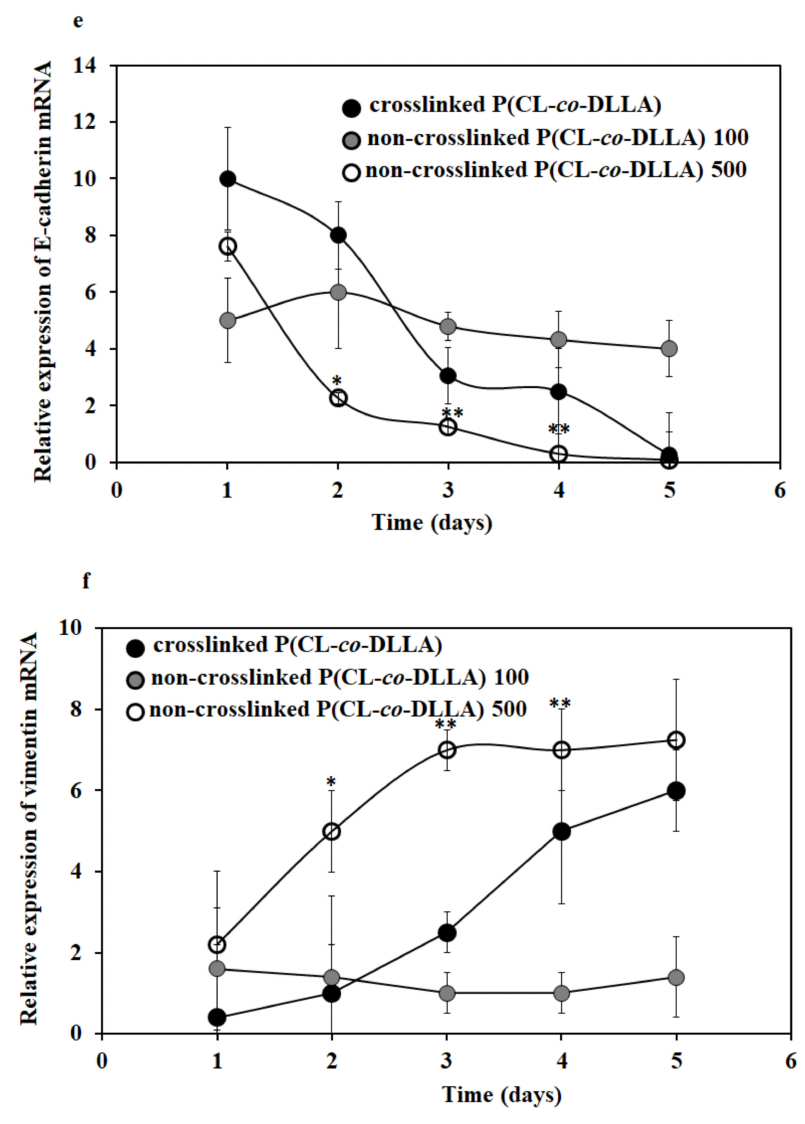
Figure 2. Biochemical evaluation of epithelial (E-cadherin) and mesenchymal (vimentin) markers in MCF-7 cells cultured on P(CL- co -DLLA) (crosslinked and non-crosslinked) substrates. The images represent the expression of E-cadherin and vimentin in MCF-7 cells at ( a ) 48 h and ( c ) 72 h. MCF-7 cells on non-crosslinked P(CL- co -DLLA) 100 substrates maintained their epithelial phenotype throughout the culture period whereas MCF-7 cells on non-crosslinked P(CL- co -DLLA) 500 substrates transformed to a mesenchymal phenotype. Quantitative determination of the percentage of E-cadherin (black bars) and vimentin (white bars) positive cells ( b ) 48h and ( d ) 72 h. In the crosslinked P(CL- co -DLLA) substrate, about 65% of cells were transformed to mesenchymal cells at 48 h and about 75% of epithelial cells were transformed to mesenchymal cells at 72 h. In the non-crosslinked P(CL- co -DLLA) 500 substrate, at 48 h, 85% of MCF-7 cells and at 72 h around 96% of the cells were transformed to mesenchymal phenotype. MCF-7 cells on non-crosslinked P(CL- co -DLLA) 100 substrates maintained their epithelial phenotype throughout the culture period. ( e ) Time-dependent quantitative representation of E-cadherin and ( f ) vimentin mRNA expression by quantitative real-time PCR (qRT-PCR) where glyceraldehyde-3-phosphate dehydrogenase (GAPDH) is used as an endogenous control of the same sample of each experiment. n = 3 ± SD, * p = 0.05 and ** p = 0.01 for non-crosslinked P(CL- co -DLLA) substrate corresponding to crosslinked P(CL- co -DLLA) substrate of the same